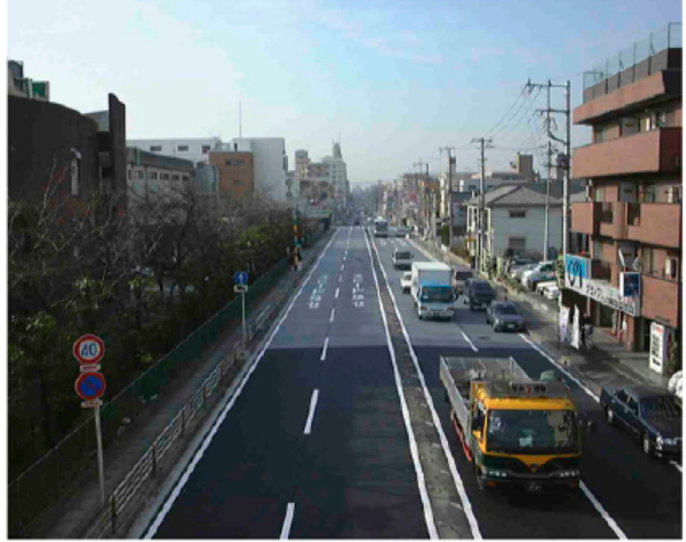
Figure 29. Usage of TiO 2 -based photocatalytic material on roadway surfaces to convert nitrogen oxides NO x to nitrate: finished roadway with the coated surface showing a lighter color—photo was courtesy of Fujita Road Construction Co., Ltd. to the authors of Ref. [117]. Reproduced with permission from Fujishima et al. [117]. Copyright 2008 by Elsevier B.V. (License No.: 4452671501245).